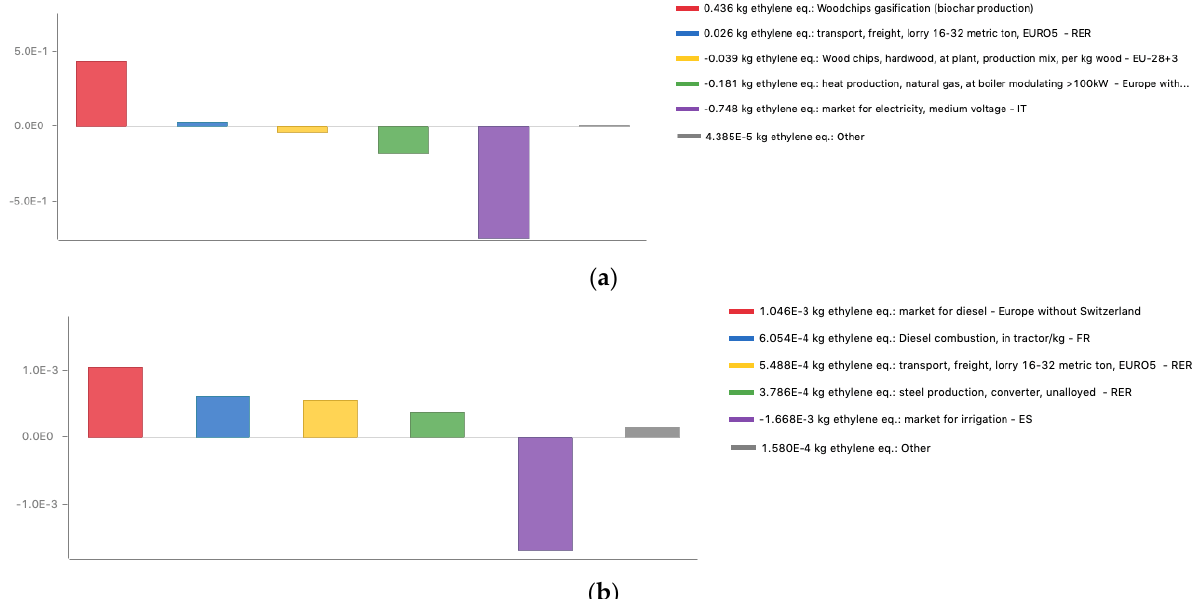
Figure 12. Photochemical oxidation: top 5 contributions impacting category results: ( a ) Cradle-to-grave analysis; ( b ) Downstream process.